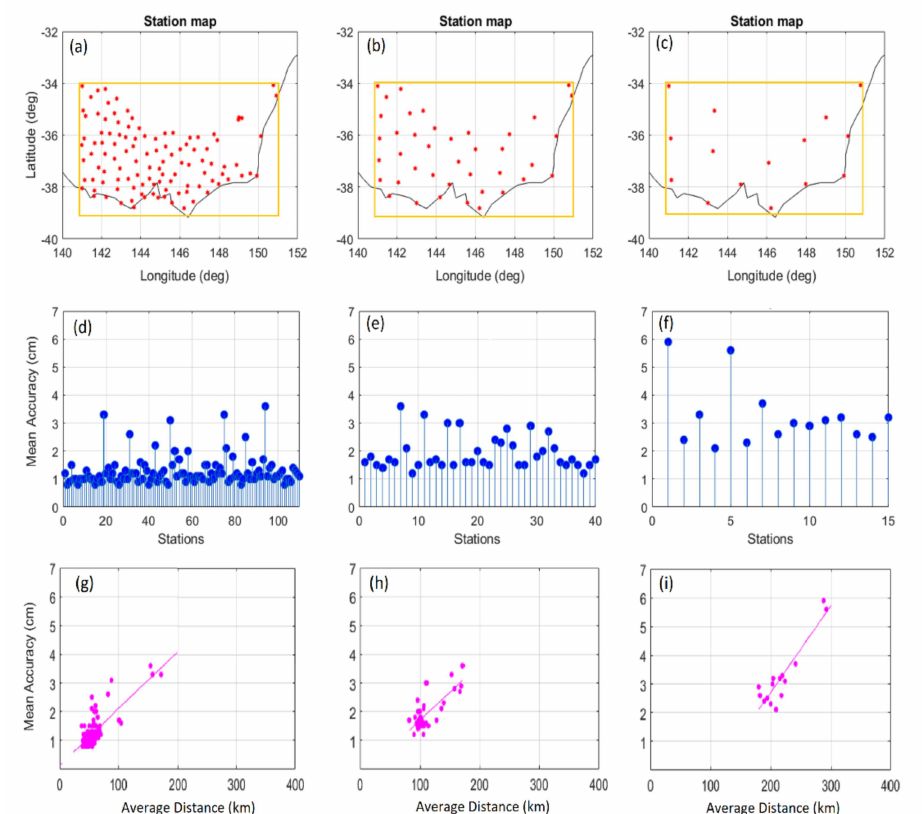
Figure 4. ( Top : a – c ) Three test scenarios in Victoria to assess the relation between the accuracy of the interpolated ionospheric corrections as function of the density of the CORS network configurations. The orange rectangles show the test area of 5 ◦ latitude × 10 ◦ longitude, and the red asterisks present for the CORS stations. ( Middle : d – f ) Plots showing the mean accuracy for each station in the corresponding network. ( Bottom : g – i ) Plots showing the accuracy of the interpolated ionospheric corrections as a function of the average separation distance between the testing station and its three nearest stations in the local